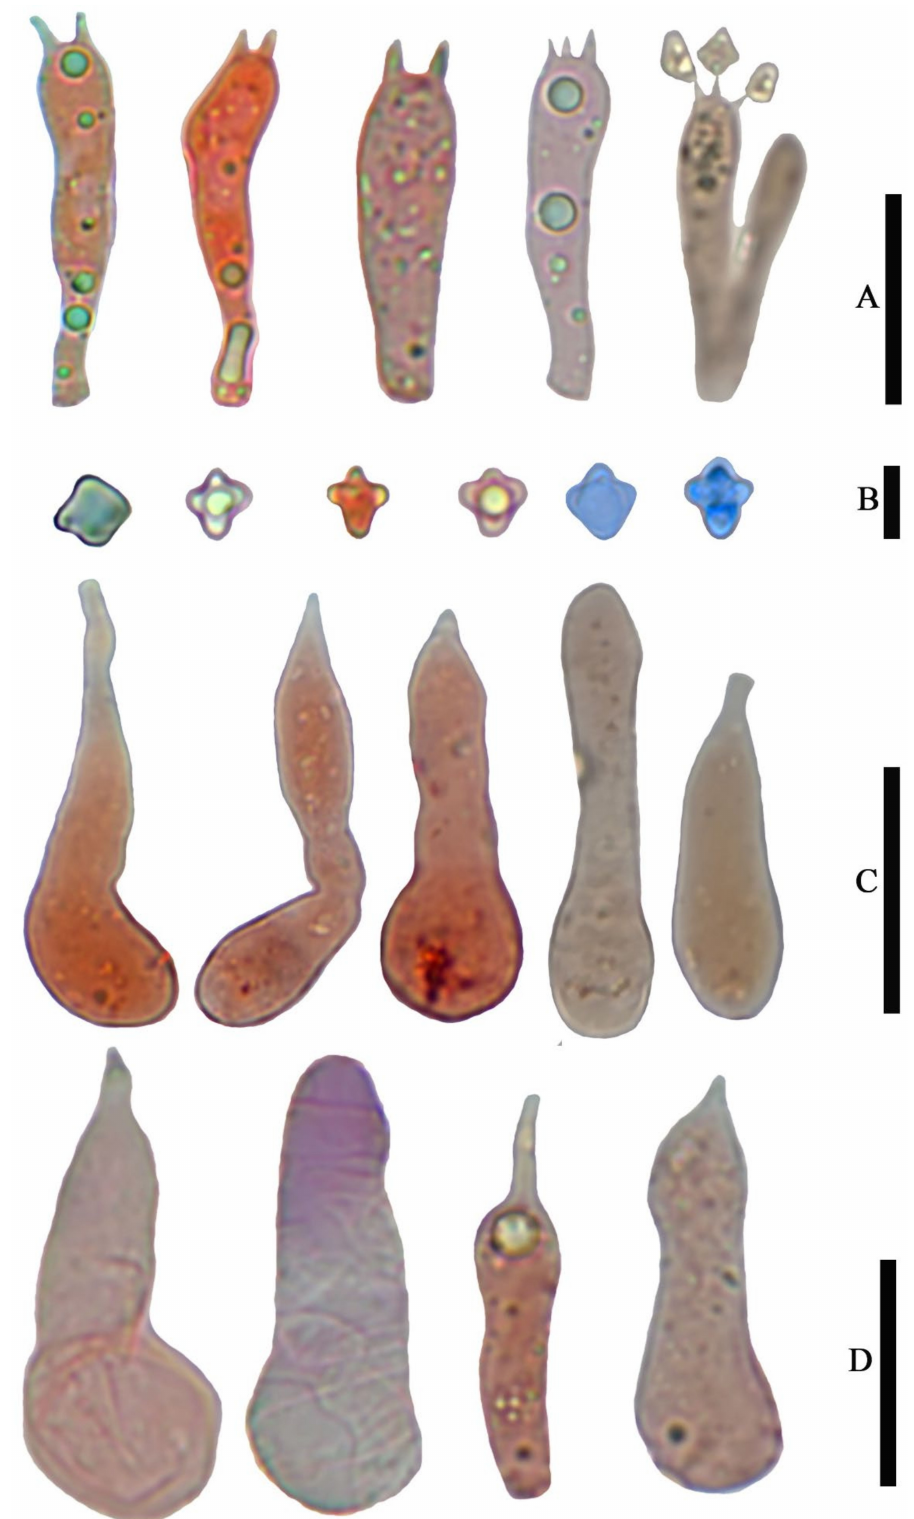
Figure 9. Microscopic features of Tricholosporum guangxiense, from HMJAU59028 (Holotype). ( A – D ) stained with 1% Congo Red solution. ( B ) (from left to right) 1–2 in pure water, 3–4 stained with 1% Congo Red solution, 5–6 stained by Cotton blue. ( A ) Basidia, ( B ) Basidiospores, ( C ) Pleurocystidia, and ( D ) Cheilocystidia. Scale bar ( A ) = 15 µ m, ( B ) = 5 µ m, ( C , D ) = 20 µ m. Photos by Guang-fu